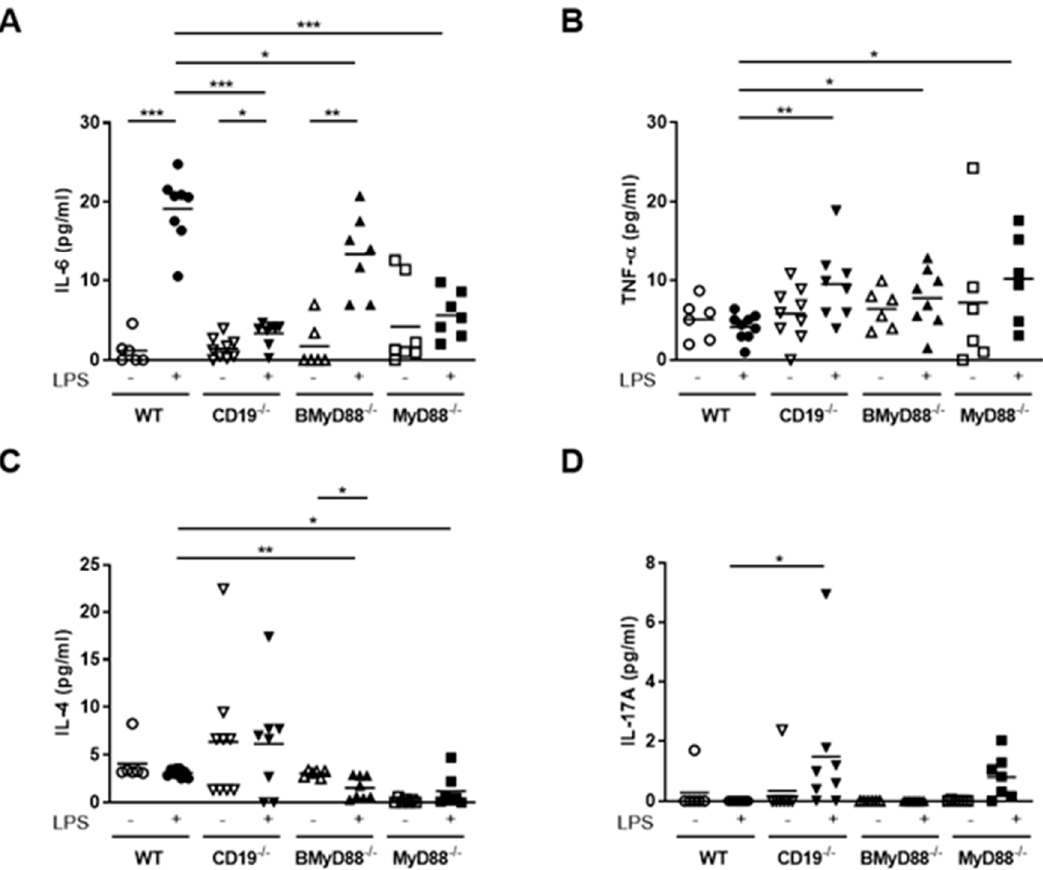
Figure 3. Cytokine levels were differently altered after in vivo LPS treatment. IL-6 ( A ), TNF- α ( B ), IL-4 ( C ) and IL-17A ( D ) levels in the serum of WT, BMyD88 -/- , CD19 -/- and MyD88 -/- mice at 24 h after LPS or PBS injection on gestational day (gd) 10 were determined by CBArray. N = 7–9 mice/group; * p < 0.05, ** p < 0.01, *** p < 0.001. Shown are the mean values.